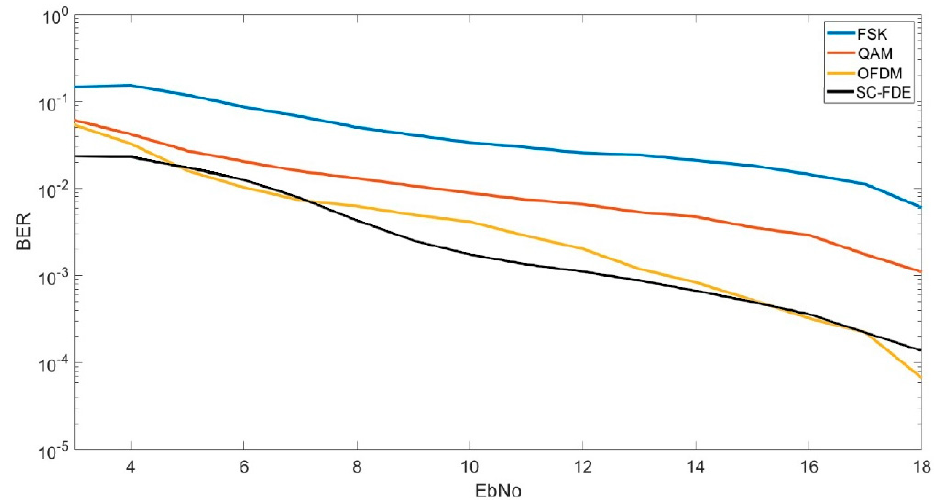
Figure 7. BER vs. EbNo comparison between FSK, QAM, OFDM, and SC-FDE. FSK and QAM need higher EbNo than the OFDM and SC-FDE, which show very similar results. For BER of 10 − 3 , the SC-FDE needs 1 dB less than the OFDM, but for BER 10 − 4 , the OFDM needs 17.5 dB and the SC-FDE needs more than 18 dB. 6.3. CR Sweep